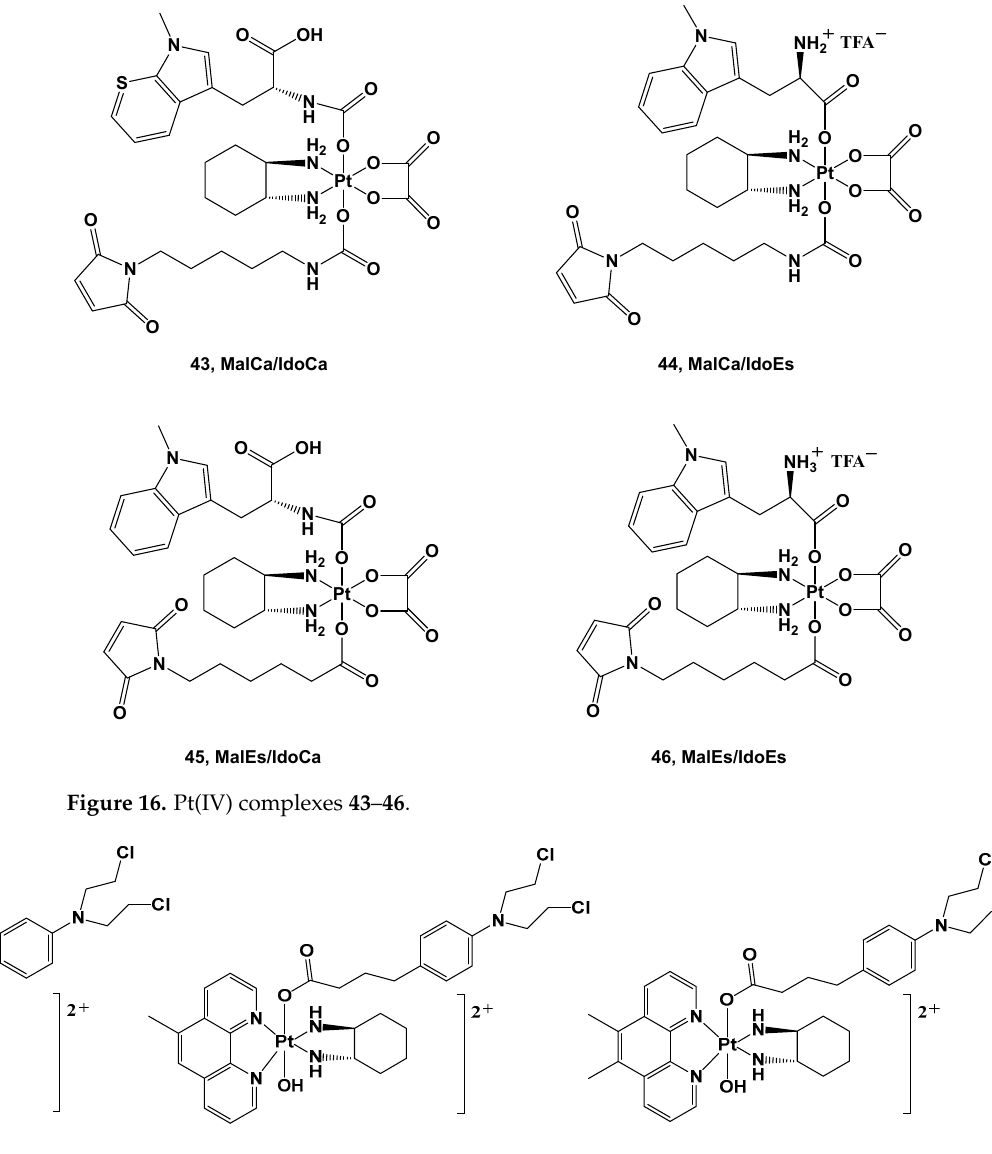
Figure 17. Pt(IV) complexes 47 – 49